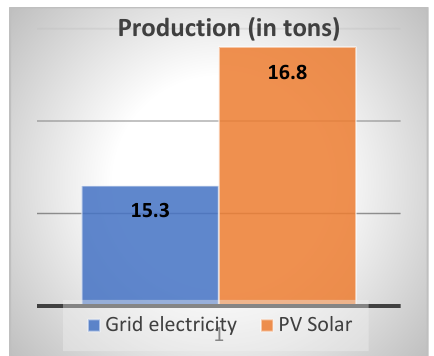
Figure 2. Production. Figure 2.